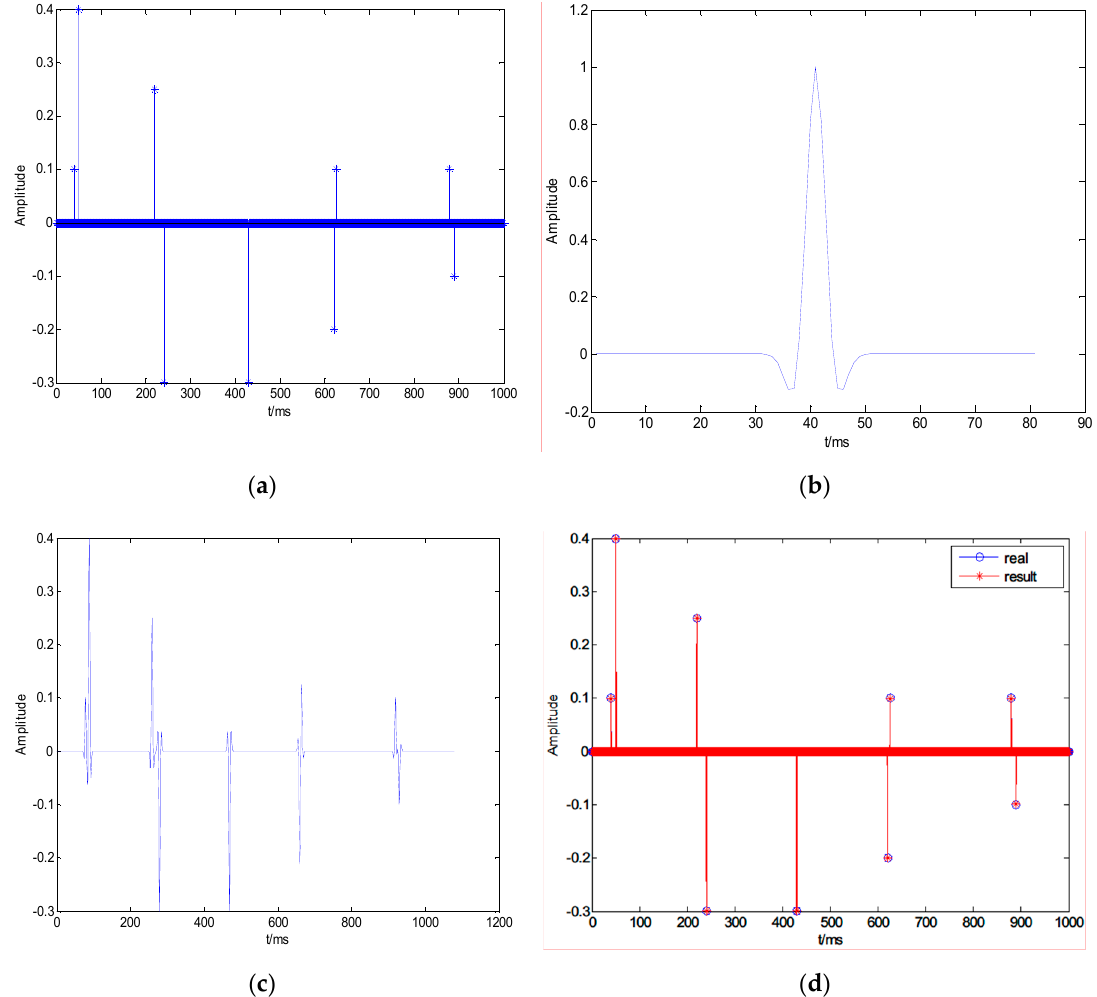
Figure 4. Inversion result of single-trace model data. ( a ) Reflection coefficient model; ( b ) Ricker wavelet; ( c ) synthetic seismogram; and ( d ) inversion result.